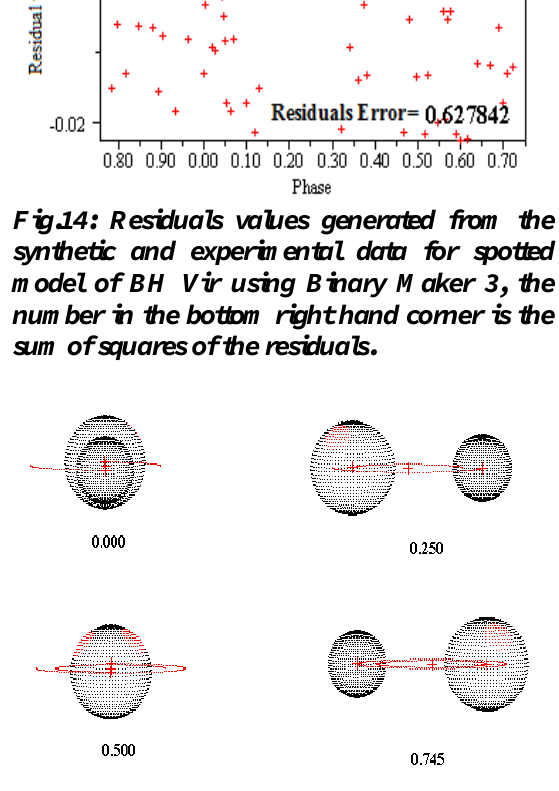
Fig.15: The shape of the spotted Model of RT And binary star at different phases.